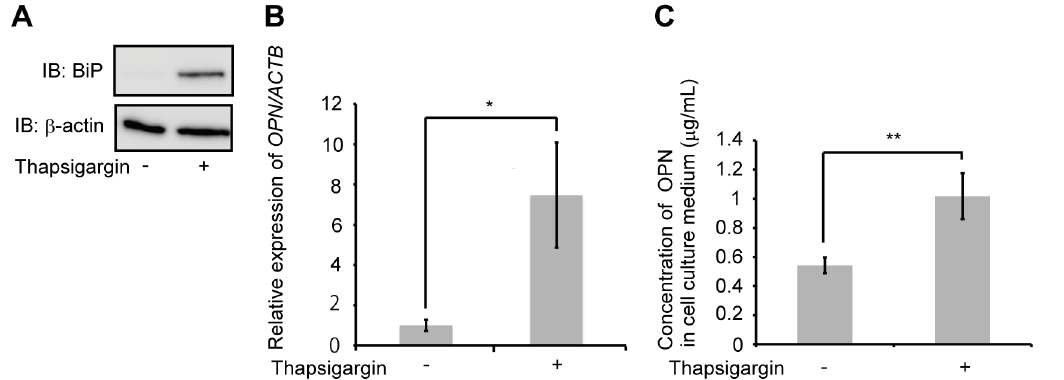
Figure 5. Effect of thapsigargin on OPN expression. (A) A549 were exposed to 10 nM thapsigargin or DMSO for 48 h. Western blotting was used to detect BiP and b -actin. (B and C) A549 were exposed to 10 nM thapsigargin or DMSO for 48 h. (B) OPN mRNA was assessed by qRT-PCR. (C) OPN concentrations in cell culture media were determined by ELISA. Data are presented as mean 6 S.E. *, P , 0.05; **, P , 0.01.